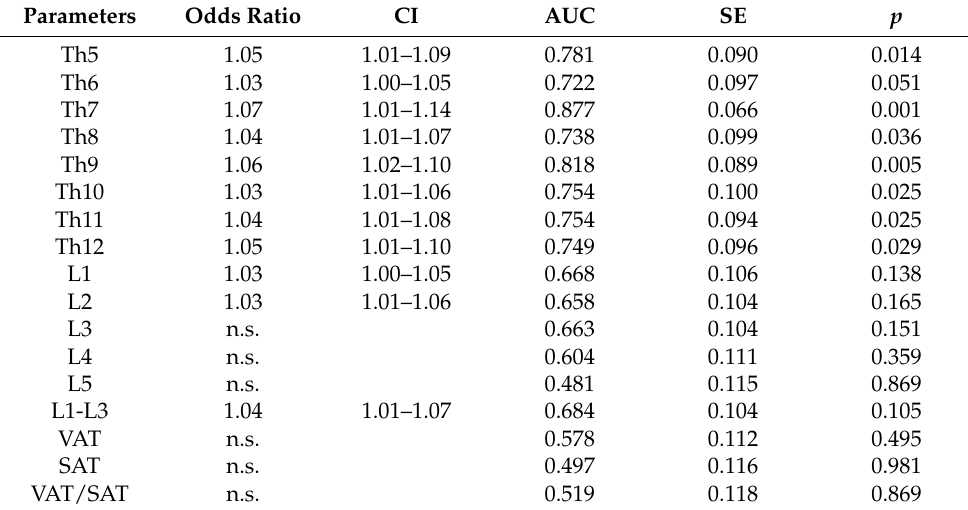
Table 2. The odds ratios with 95% Confidence Interval per BMD SD decrease as well as area under the curve values of the areal bone mineral density from Th5 to L5, subcutaneous adipose tissue and visceral adipose tissue in patients with incident fractures versus